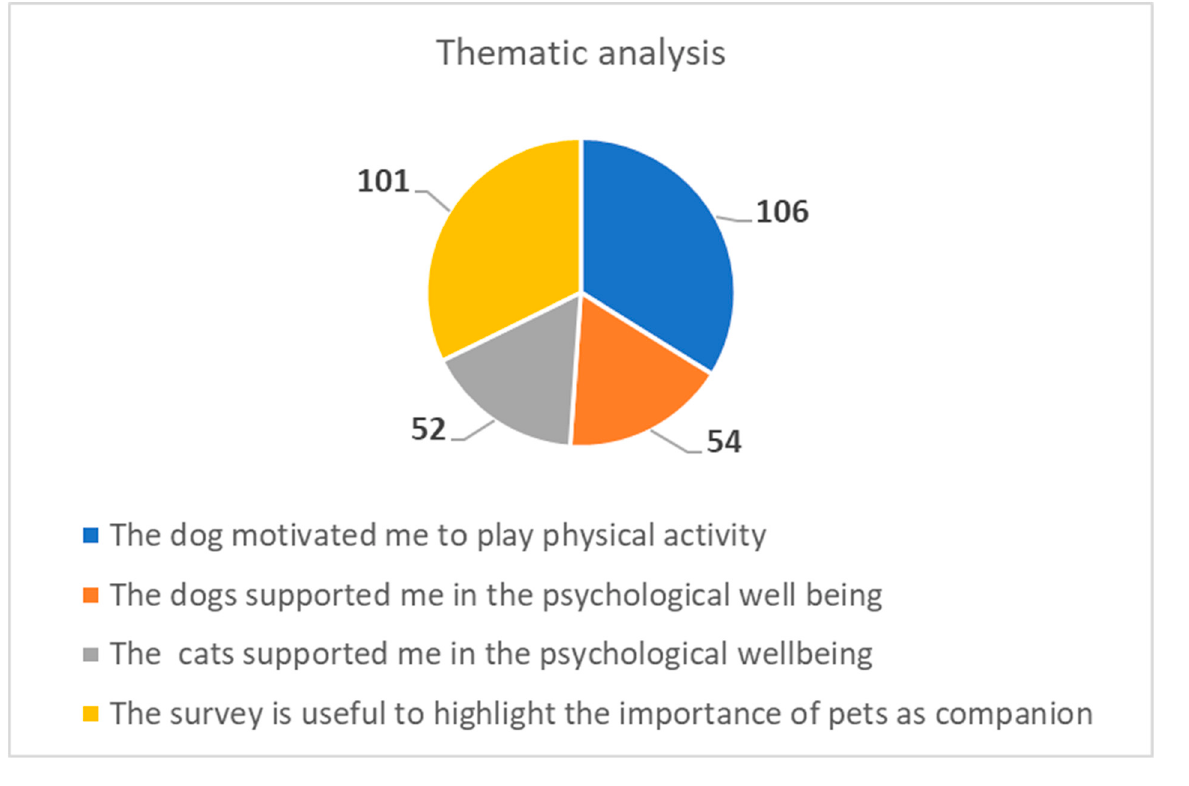
Figure 5. Outcome on the thematic analysis on the comments.